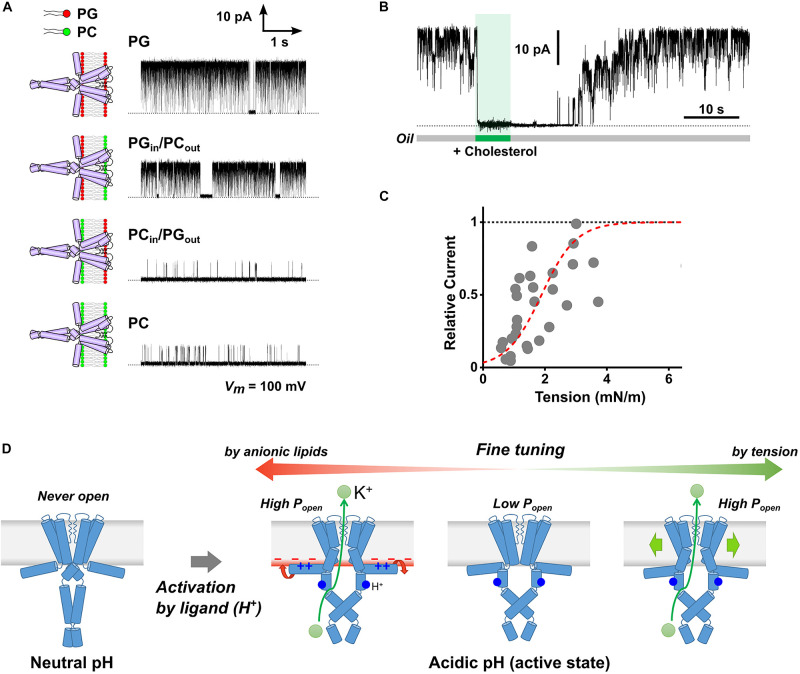
Membrane effects on the KcsA channel activity. (A) Typical single-channel current traces of the KcsA channel in the symmetric and asymmetric membranes under acidic pH. The membranes were formed using phosphatidylglycerol (PG, anionic) and phosphatidylcholine (PC, neutral). The electrolyte solution contained 200 mM KCl, and the membrane potential was 100 mV. (B) Inhibitory effect of cholesterol on the KcsA channel. The current was immediately attenuated upon cholesterol administration to the lipid bilayer (5 mg/ml) by membrane perfusion. The channel current was recovered in the original level some time after the perfusion was stopped, indicating that cholesterol diffused from the membrane; the number of channels in the membrane was constant throughout the perfusion process. (C) Membrane tension dependency of KcsA channel activity. The broken red line represents a Boltzmann fit where ΔG0/kBT is 3.37 ± 0.37, ΔA is 7.33 ± 1.23 nm2, and T1/2 of 1.89 ± 0.14 nM/m. (D) Scheme for multimodal regulation of KcsA channel activity by channel-membrane interplay. When the channel remained at rest at neutral pH, it did not open even in the presence of anionic lipids or under high membrane tension. Once activated by H+-binding (acidic pH), the channel exhibits variable activity depending on the cytoplasmic leaflet’s lipid composition or the membrane tension. Panels (A) (Iwamoto and Oiki, 2015), (B) (Iwamoto and Oiki, 2017), and (C) (Iwamoto and Oiki, 2018) are modified from the original papers, respectively.